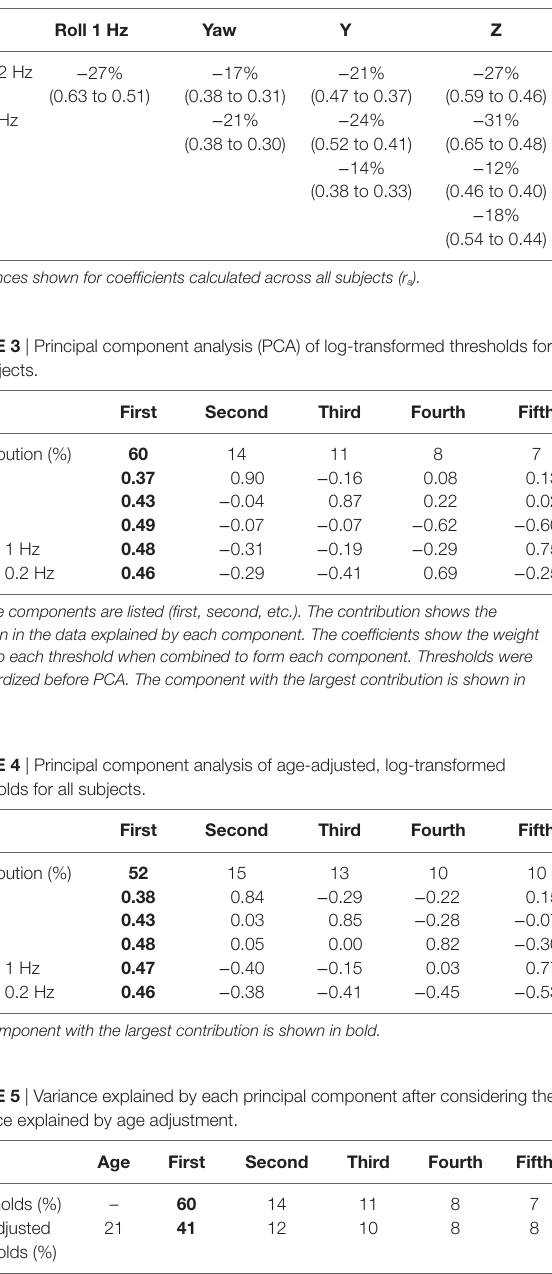
component with the largest contribution is shown in bold.